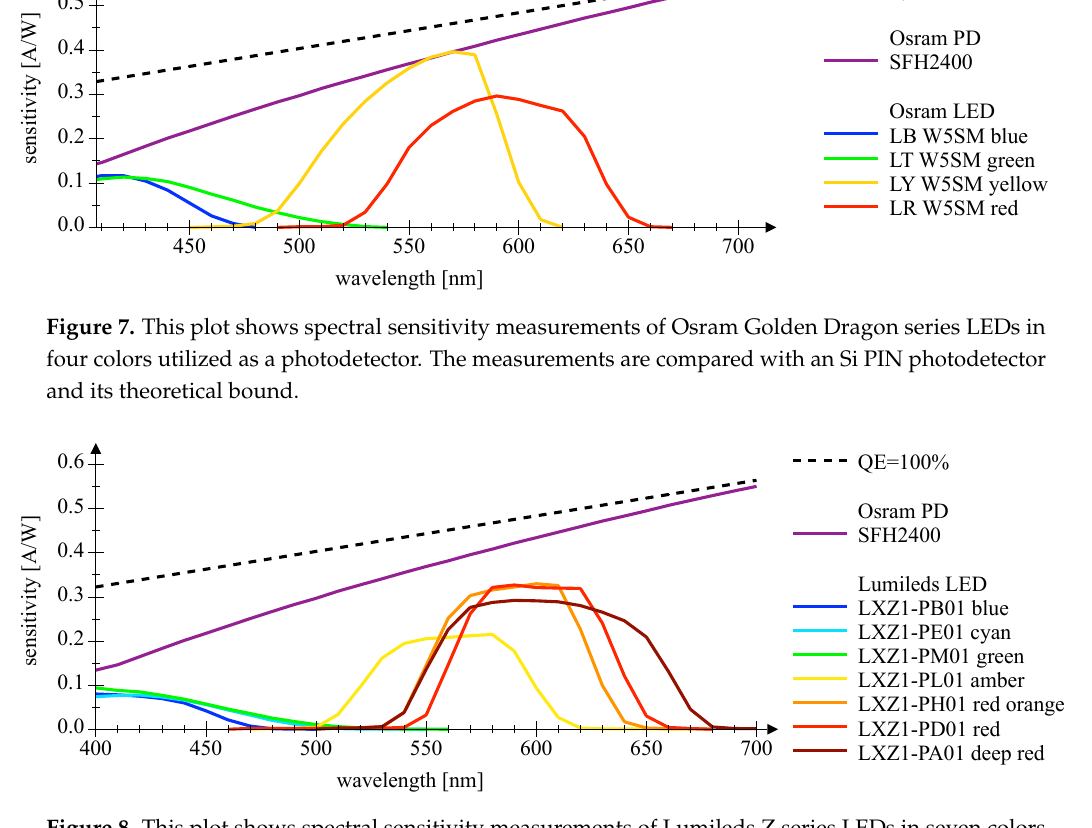
Figure 8. This plot shows spectral sensitivity measurements of Lumileds Z series LEDs in seven colors utilized as a photodetector. The measurements are compared with an Si PIN photodetector and its theoretical